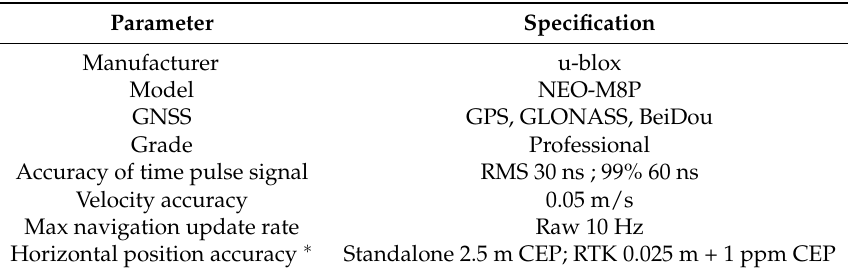
Table 3. Global navigation satellite system (GNSS) used for the navigation